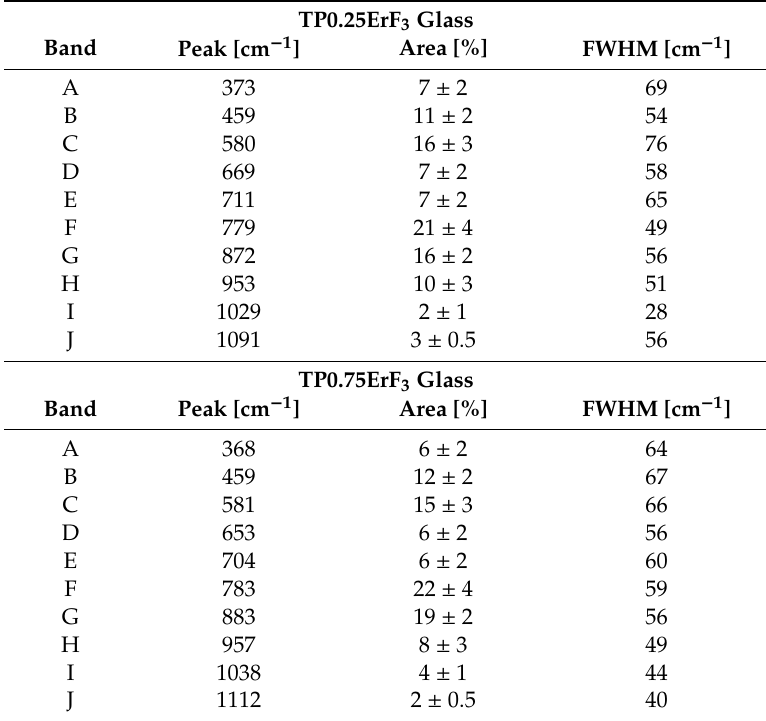
Figure 12. Plot of bands position and their area for deconvoluted Raman spectra of TP0.25ErF 3 , TP0.75ErF 3 , and TP1.25ErF 3 glasses. Table 4. The parameters of bands for the deconvoluted Raman spectra of TP0.25ErF 3 , TP0.75ErF 3 , and TP1.25ErF 3 glasses.